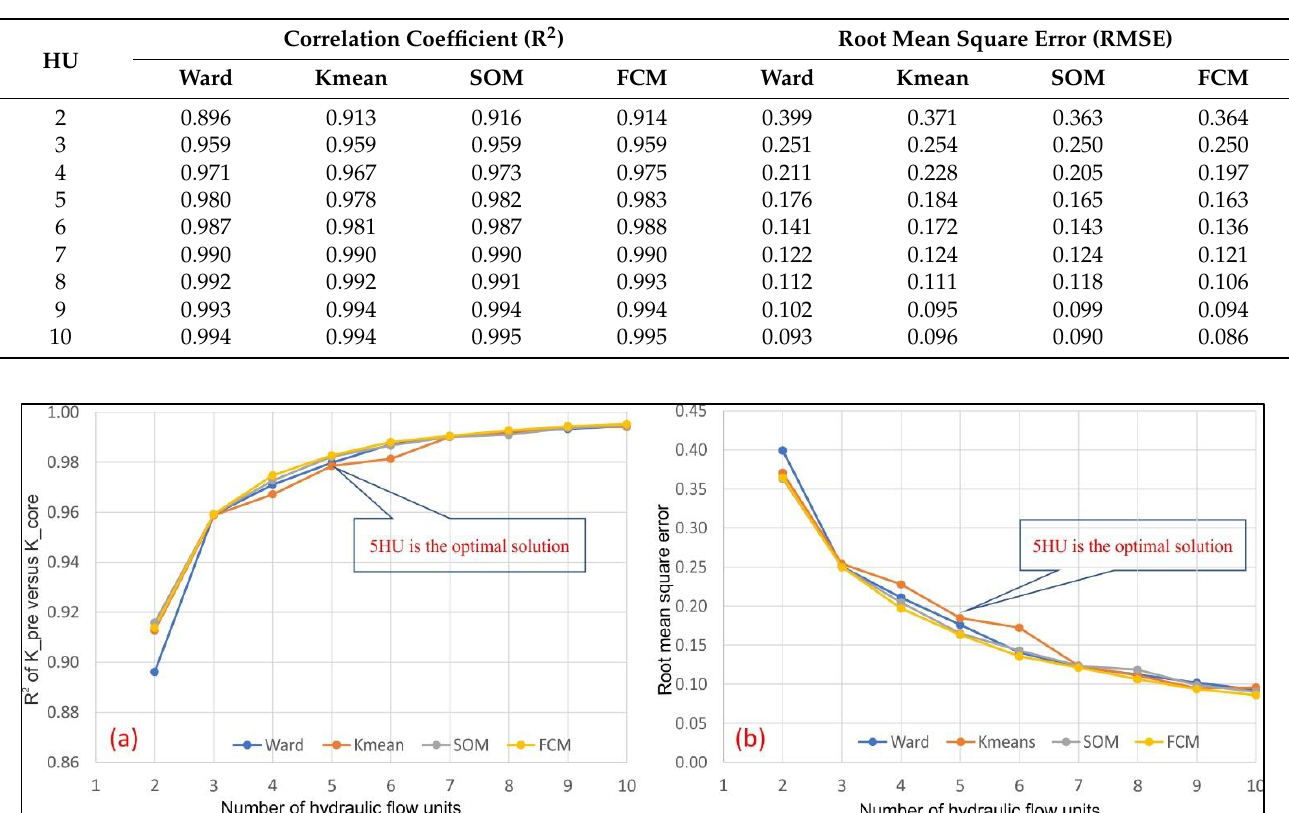
Table 1. The results of R 2 and MRSE for unsupervised clustering range from 2–10 HU clusters.